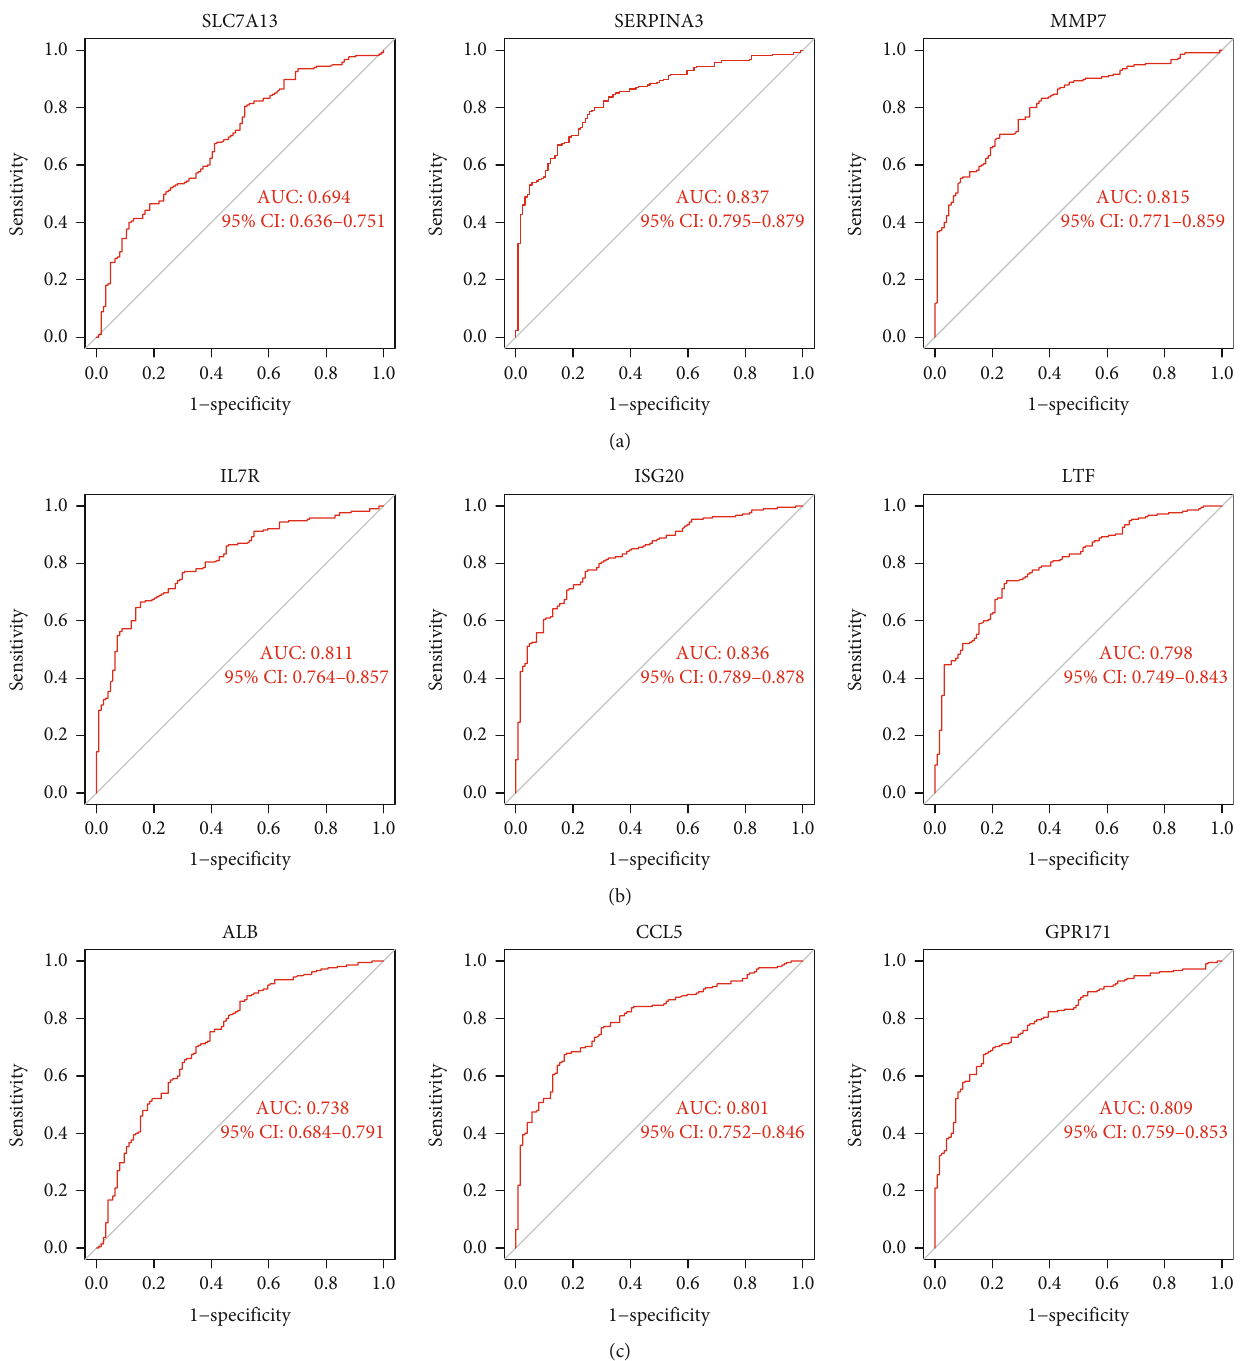
Figure 5: ROC assays were applied to determine the diagnostic value of the critical genes, including (a) SLC7A1, SERPINA, and MMP7; (b) IL7Rs, ISG20, and LTF; and (c) ALB, CCL5, and